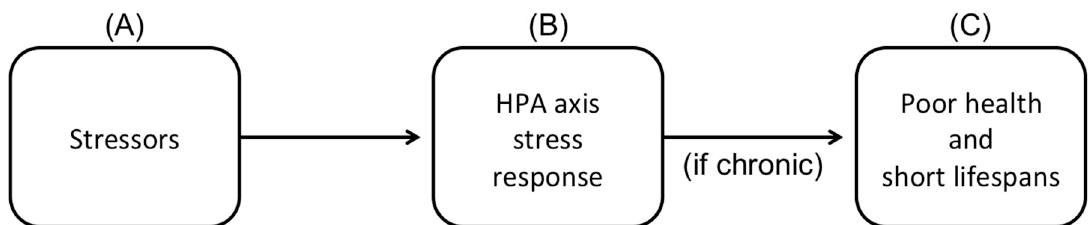
Figure 1. Schematic depiction of the causal chain leading from stressors to stress response to health effects.